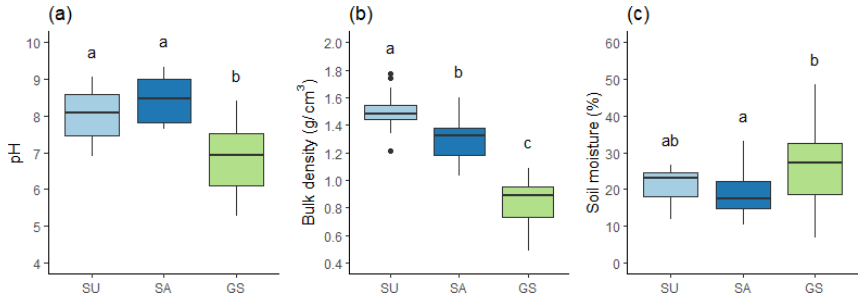
Figure 3. Soil properties: (a) pH, (b) bulk density (gcm − 3 ), and (c) soil moisture content (%) for the SU ( n = 22), SA ( n = 14), and green space (GS; n = 32) soils. Boxplots show upper and lower quartiles, whiskers show upper and lower most values, and horizontal line shows the median. Circled data points show outliers at 1.5 times the interquartile range (IQR). Different letters indicate a statistically significant difference between soil categories at the 0.05 level.